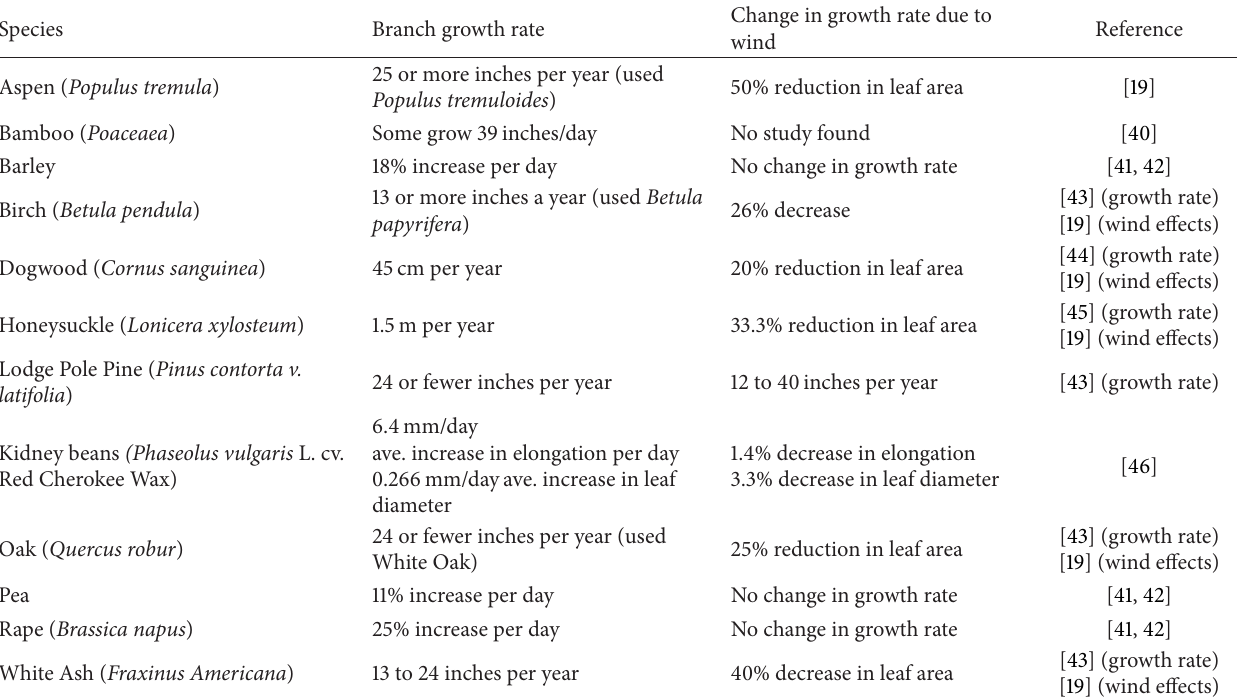
Table 1: Growth rates for plant species.